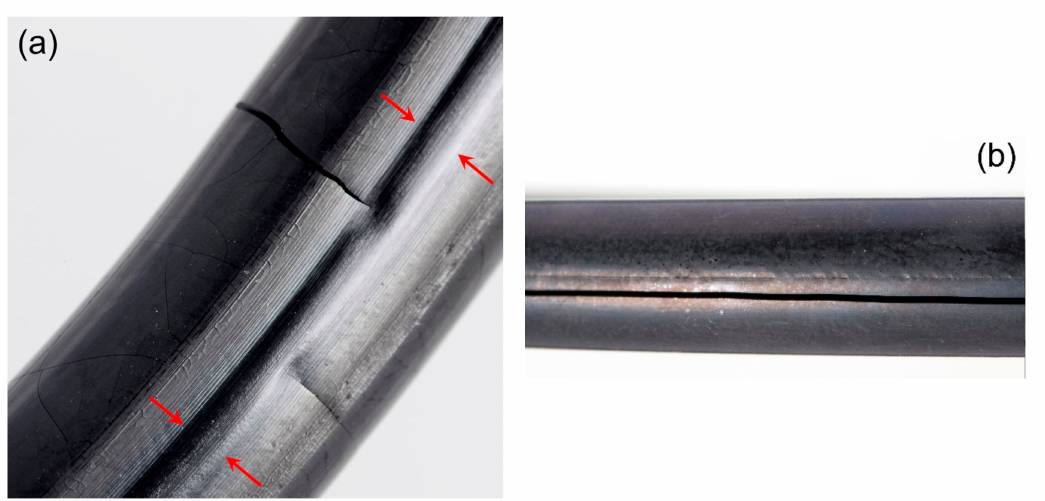
Figure 12. ( a ) Photo of seal N2 after failure and aging for 224 days at 150 ◦ C. Red arrows indicate the recovered narrow rubbery region on the seal face. ( b ) Photo of EPDM O-ring aged in the uncompressed state for 1 year at 150 ◦ C with a deep circumferential crack.